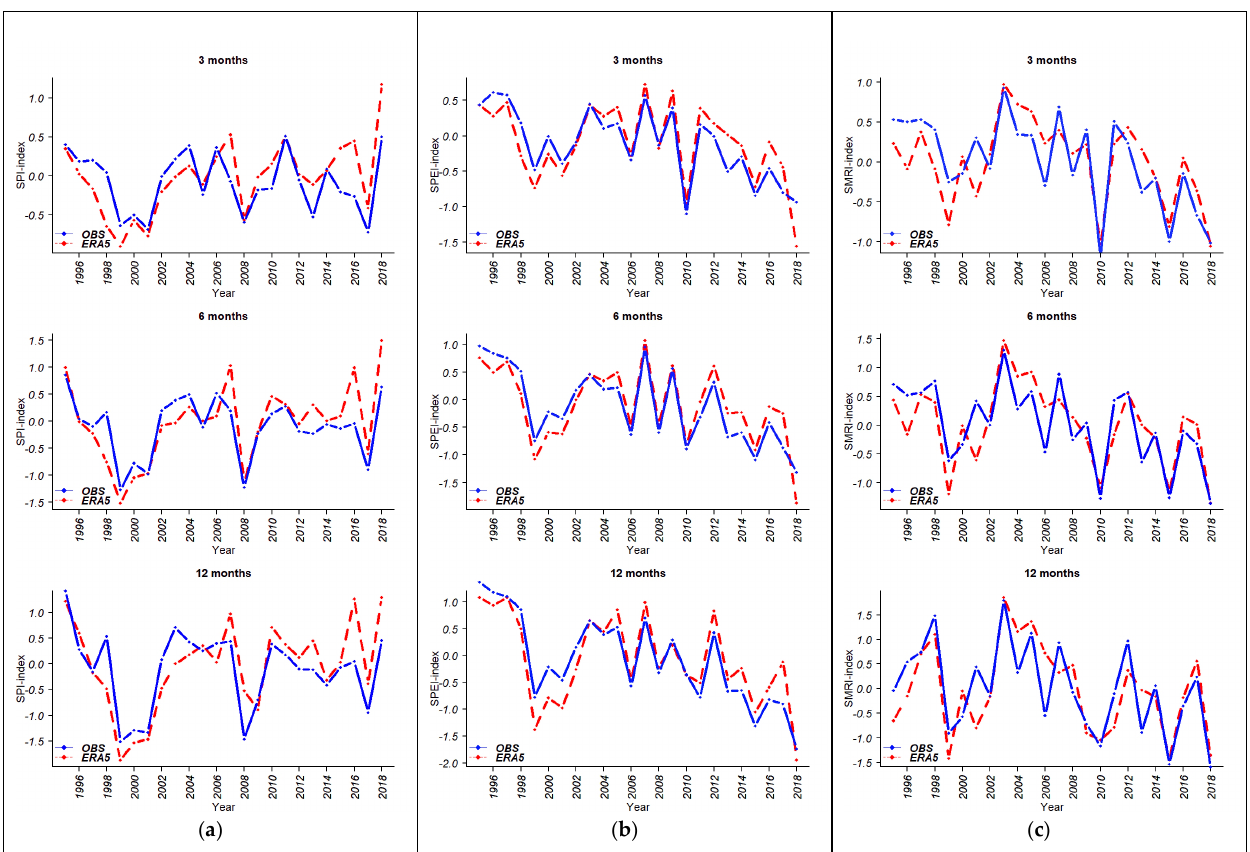
Figure 6. Time series showing 3-, 6- and 12- months accumulated values of SPI ( a ), SPEI ( b ) and SMRI ( c ) indices based on ERA5 (red) and observation (blue).